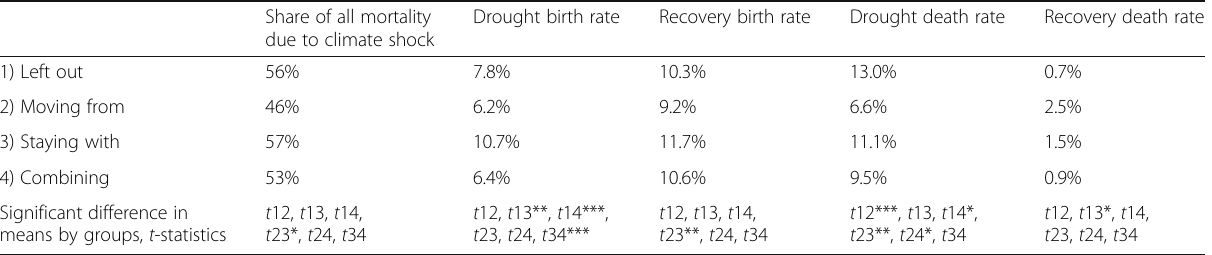
Table 4 Mortality due to climate shock and 3-month birth, death rates drought and recovery